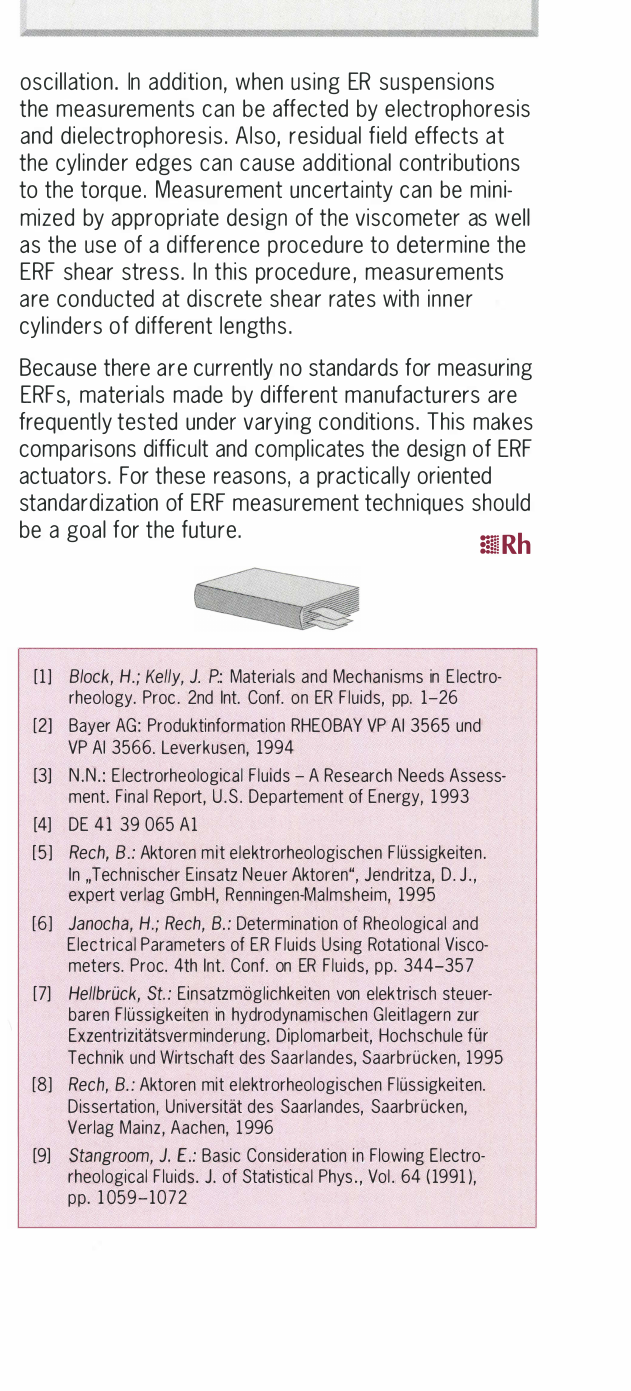
Fig. 5: Shear rate as a function of torque M; (symbols:<>, o,t.J and Mgap (symbols:+, x, * I at various field